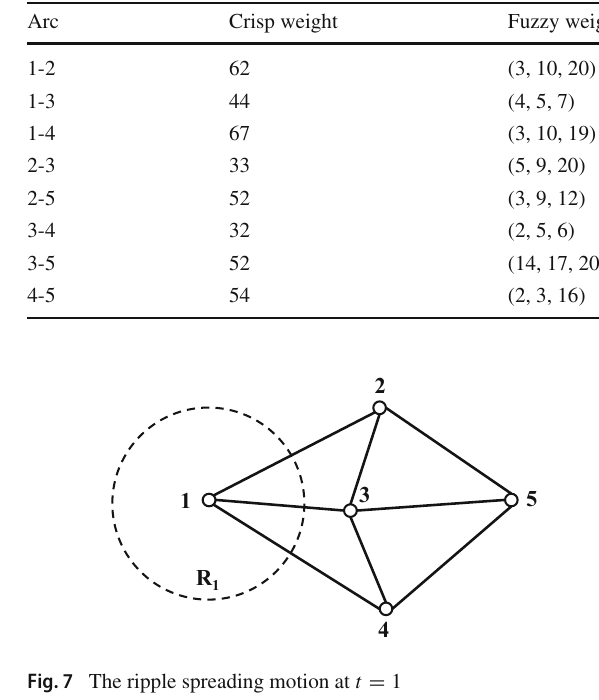
29) at node 4. R 2 triggers R 5 (green, radius = 20) at node 4 and triggers R 6 at node 5 (black, radius = 0), as shown in Fig. 9. It is worth noticing that R 2 reaches node 2, and R 3 reaches node 3, but they do not trigger any ripple. Take R